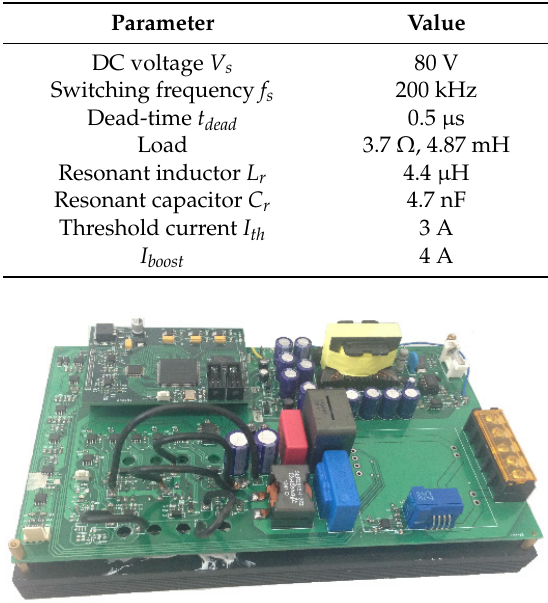
Table 2. Parameters of the circuit.